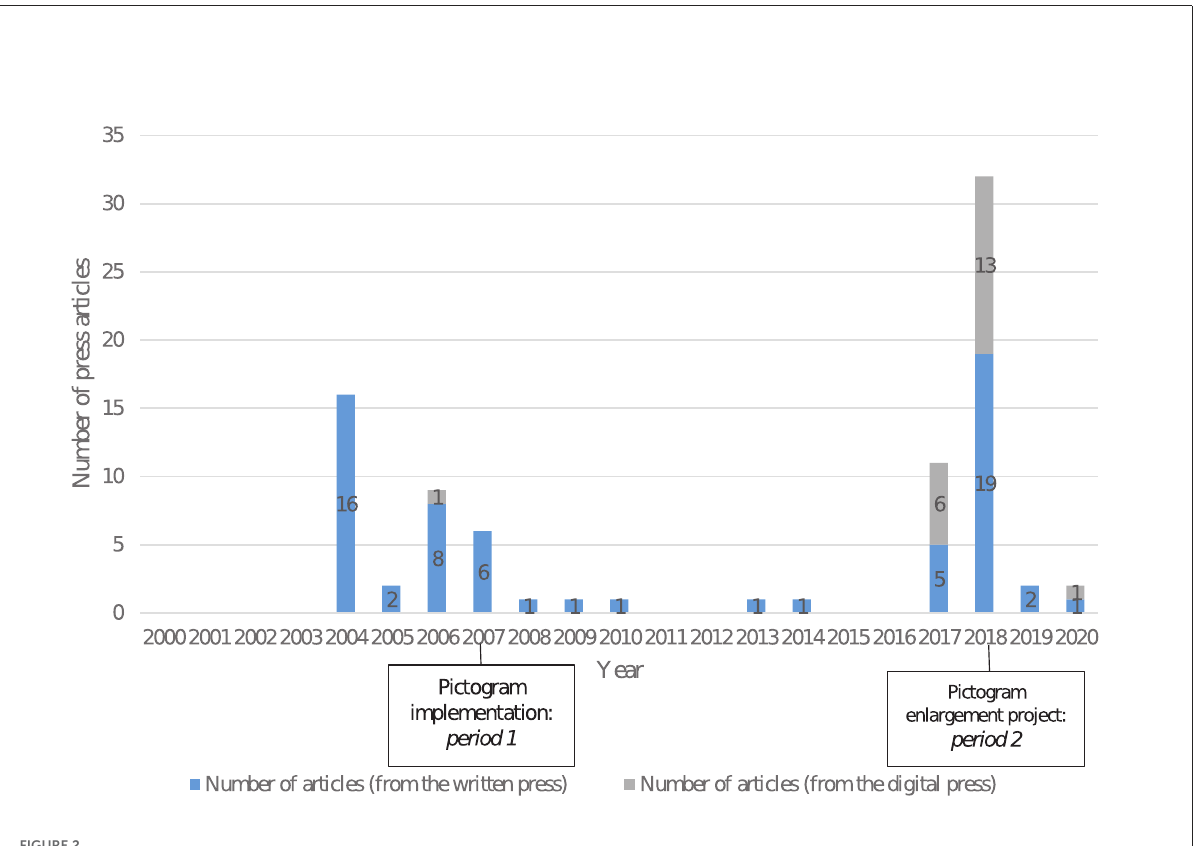
FIGURE2 Analyzed press articles published between 2000 and 2020, found in the Europresse